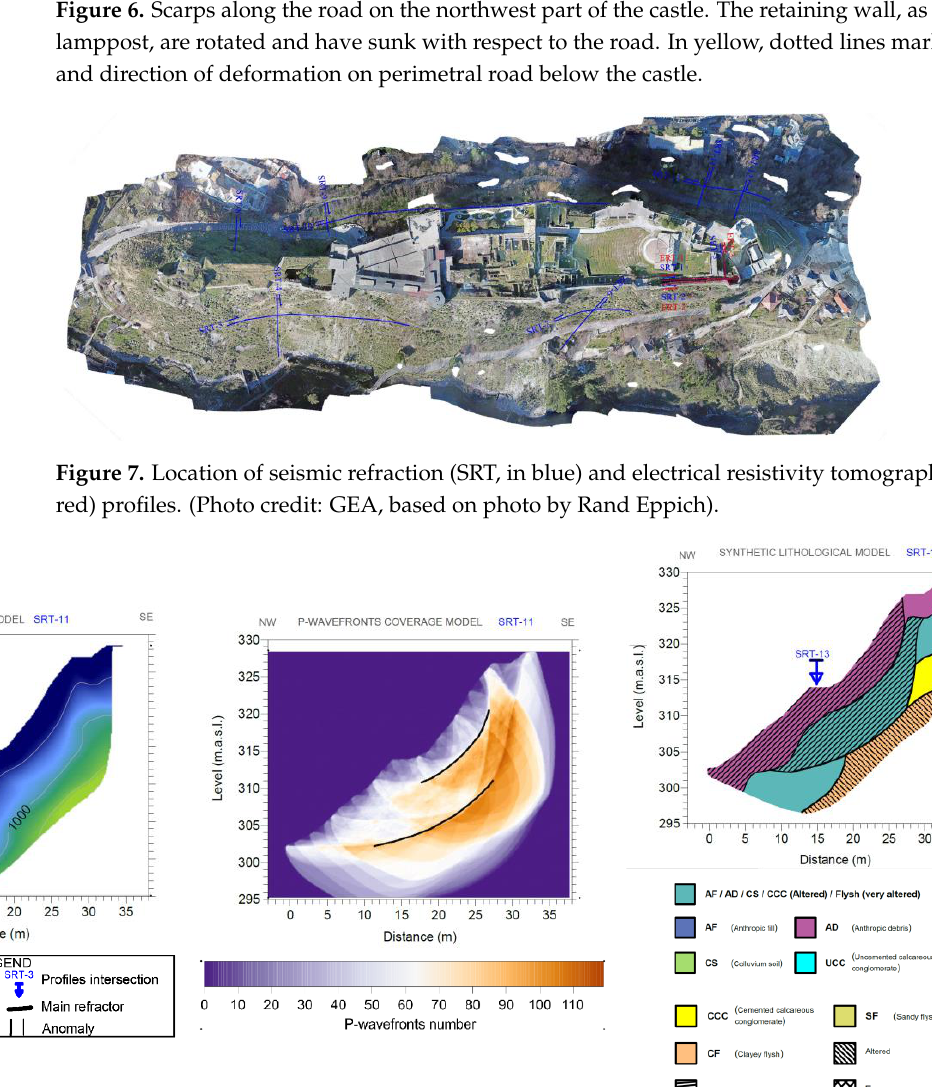
Figure 8. Example of SRT results: P-wave velocity model, P wavefront coverage model and synthetic lithological model obtained for